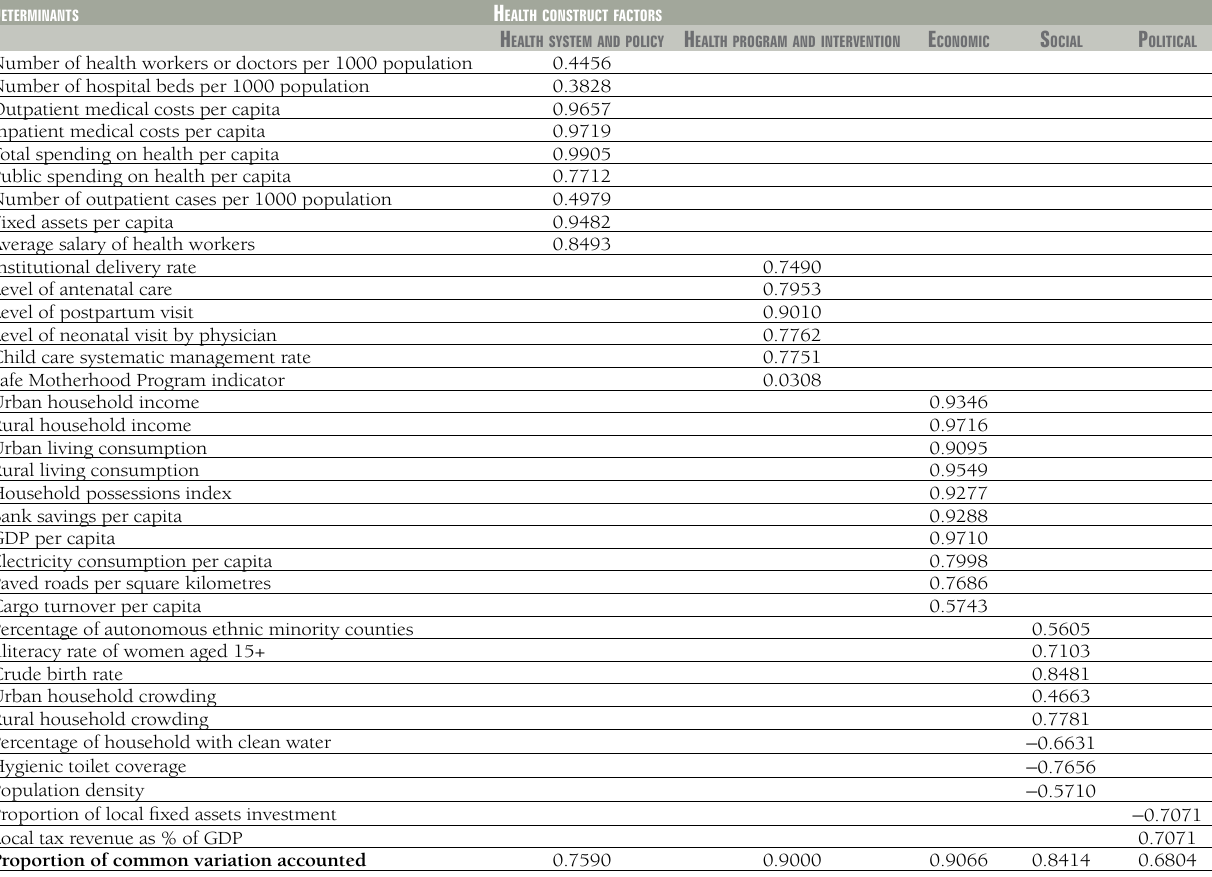
Table 1 Loading scores of determinants in their corresponding construct d eterminantS